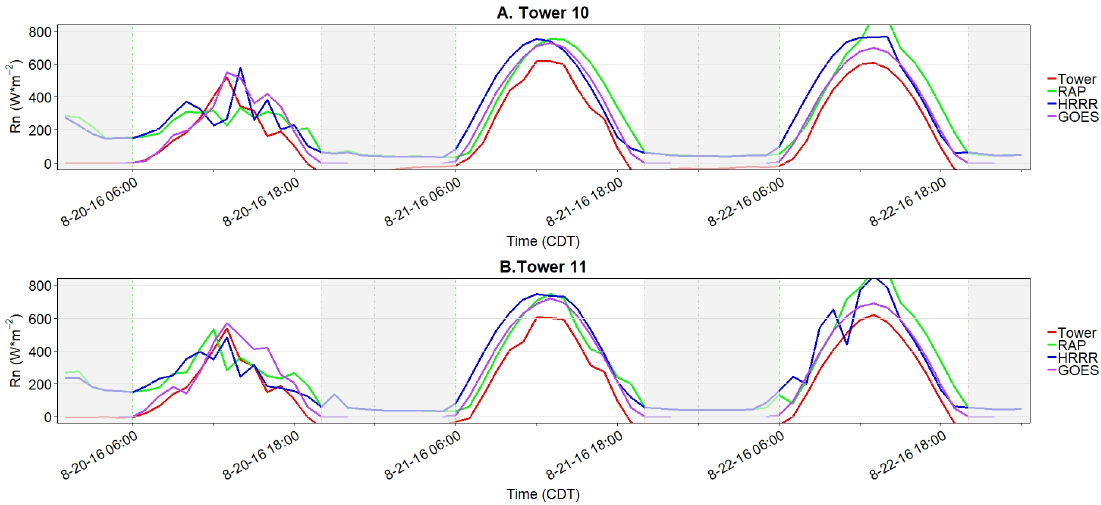
Figure 8. Time series of hourly Rn estimates from three models on a few selected days against Rn from two towers in late August 2016. The hours are in Central Daylight Time (CDT).